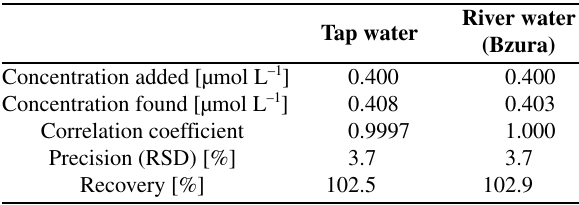
Table 2. Quantitative assay results from aclonifen spiked water and mean recovery